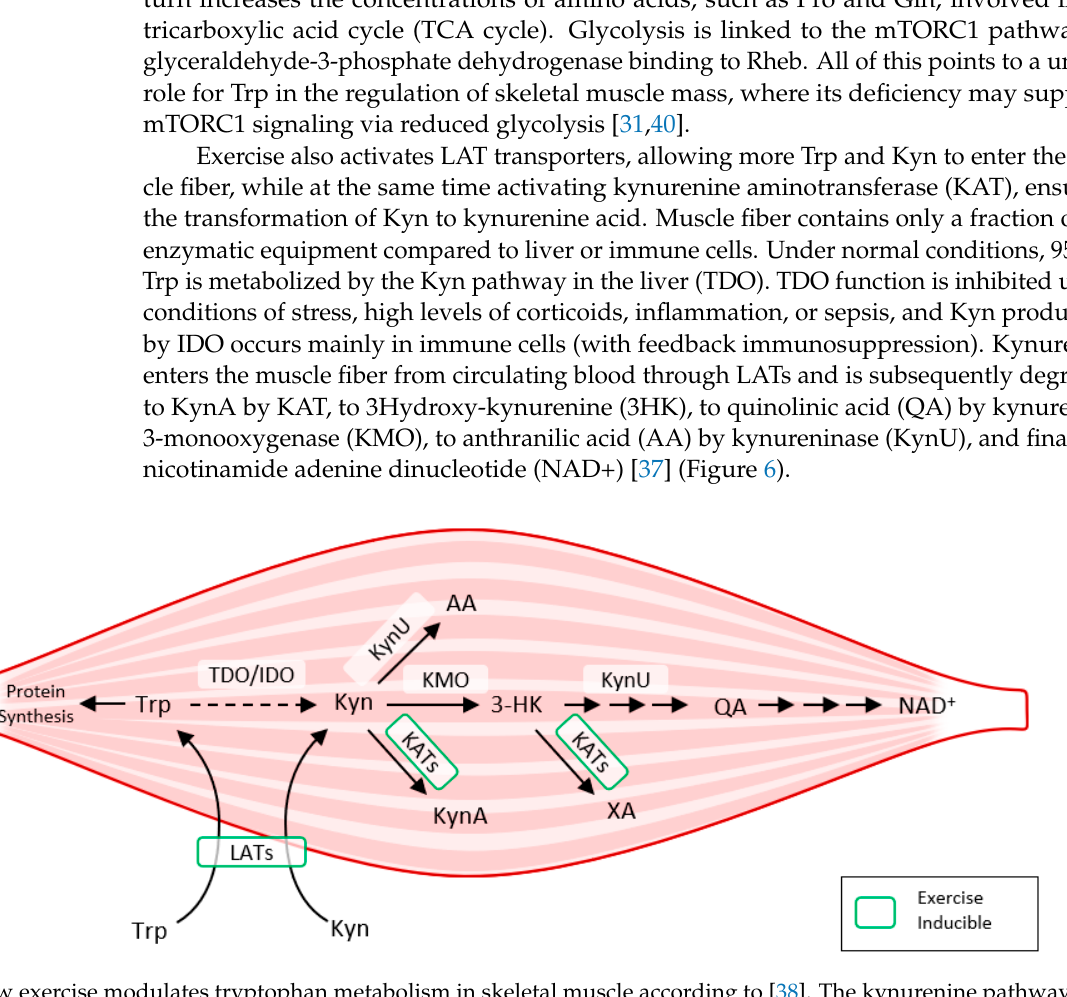
Figure 6. How exercise modulates tryptophan metabolism in skeletal muscle according to [38]. The kynurenine pathway of tryptophan degradation in skeletal muscle. Trp metabolites: Trp, Tryptophan; Kyn, Kynurenine; 3-HK, 3-Hydroxy- kynurenine; KynA, Kynurenic acid; AA, Anthranilic acid; QA, Quinolinic acid; Enzymes: TDO, Tryptophan 2,3-dioxygenase; IDO, Indoleamine 2,3-dioxygenase; KynU, Kynureninase; KATs, Kynurenine aminotransferases; KMO, Kynurenine 3-monooxygenase; LATs, large neutral amino acid transporters.